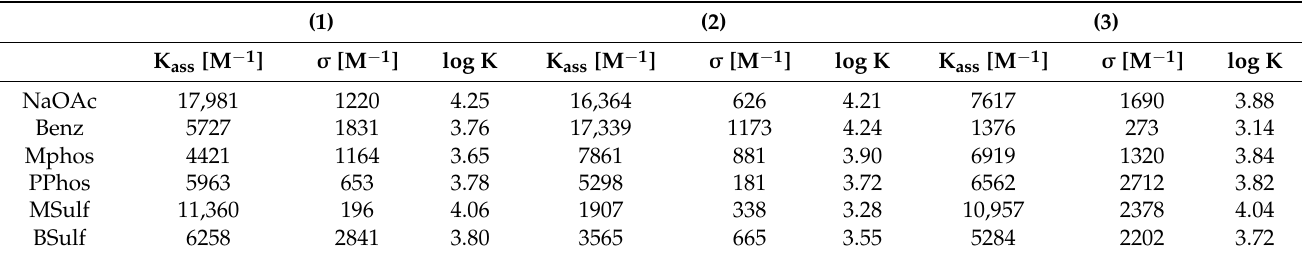
Table 2. Association constants (K ass and log K) and standard deviations ( σ ) as calculated with http://supramolecular.org (accessed on 4 April 2022) for the 1:1 complexes formed between ( 1